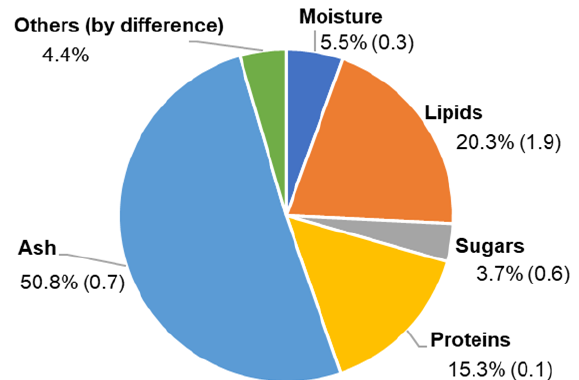
Figure 1. Composition of Emiliania huxleyi biomass (% of freeze-dried sample weight). Values are means of three replicates (standard deviations in parentheses).